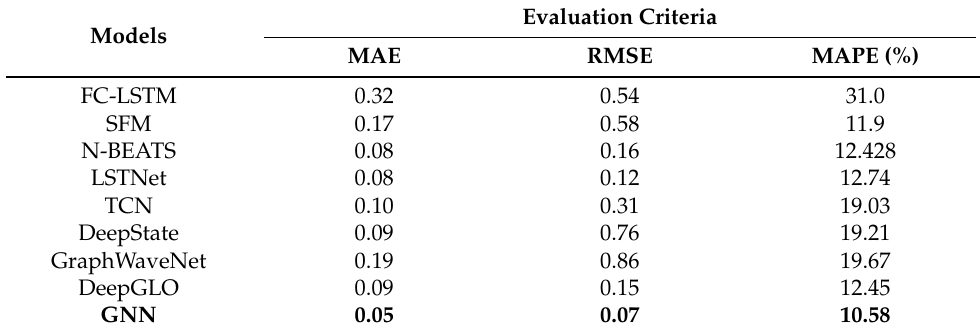
Table 2. Comparative experimental results.